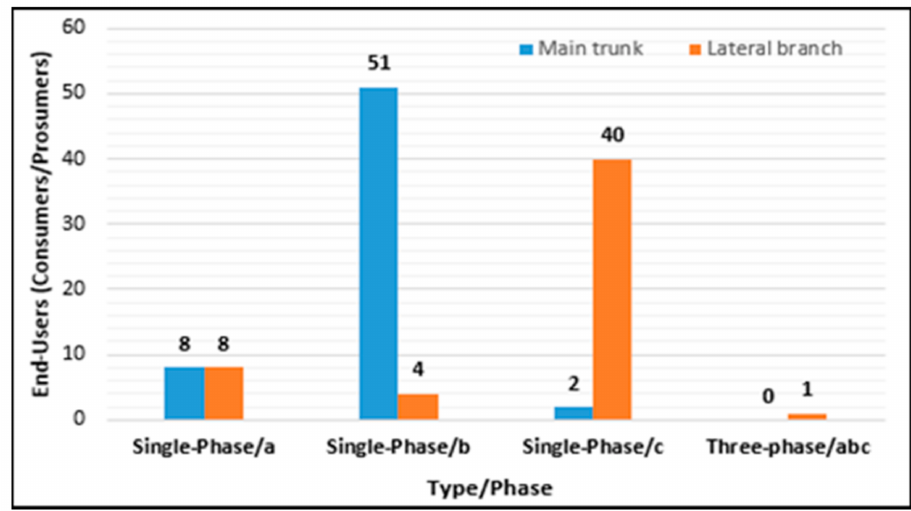
Figure 10. The type of the end-users (consumers/prosumers) and their allocation on the phases of the analysed